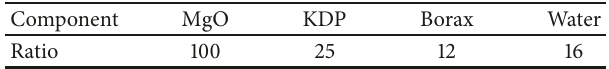
Table 3: Basic formula of MKPC.